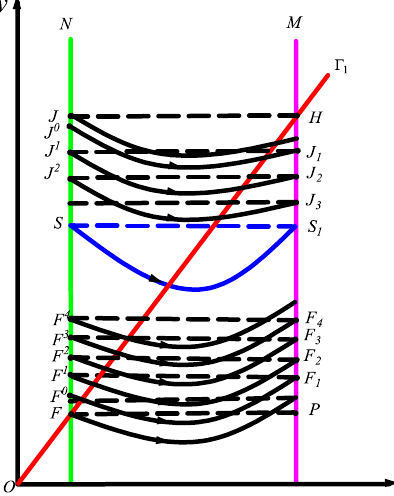
Figure 4. The orbitally asymptotically stable and global attractive of order-one periodic orbit of system